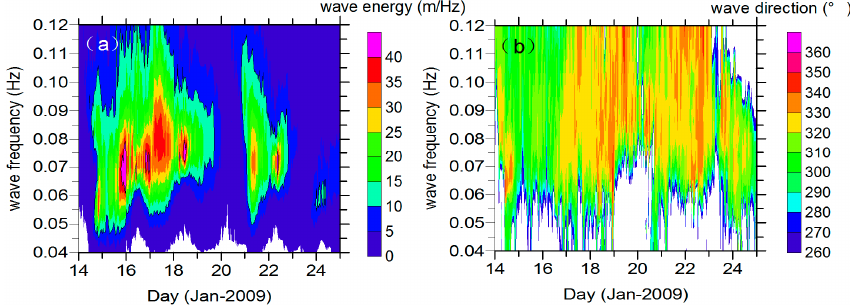
Figure 2. ( a ) Wave energy and ( b ) wave direction contour of buoy 51001.